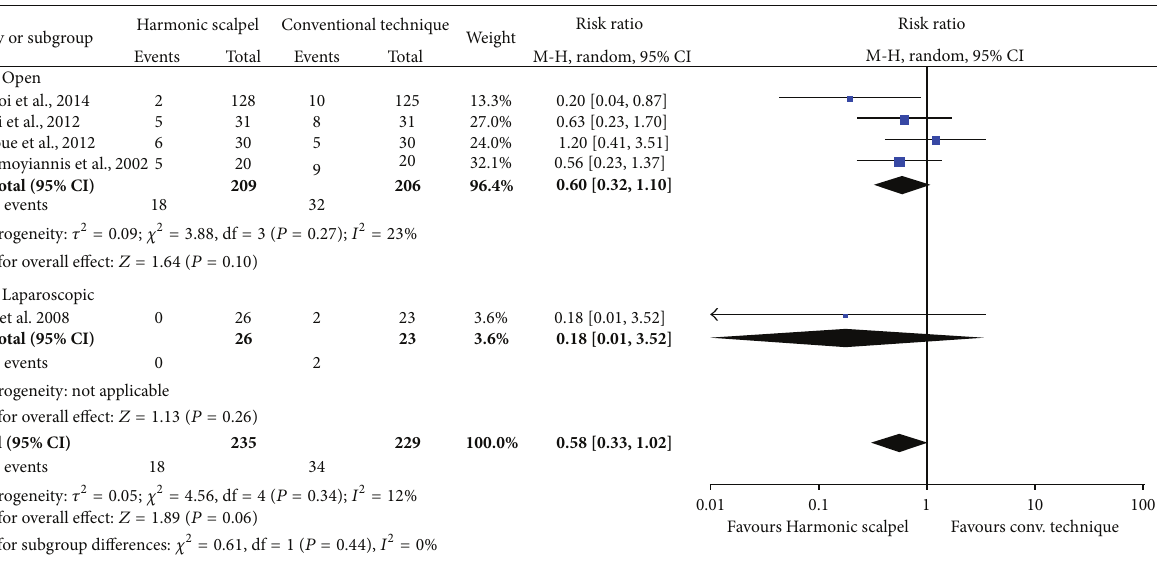
Figure 8: Forest plot of meta-analysis results for total complication